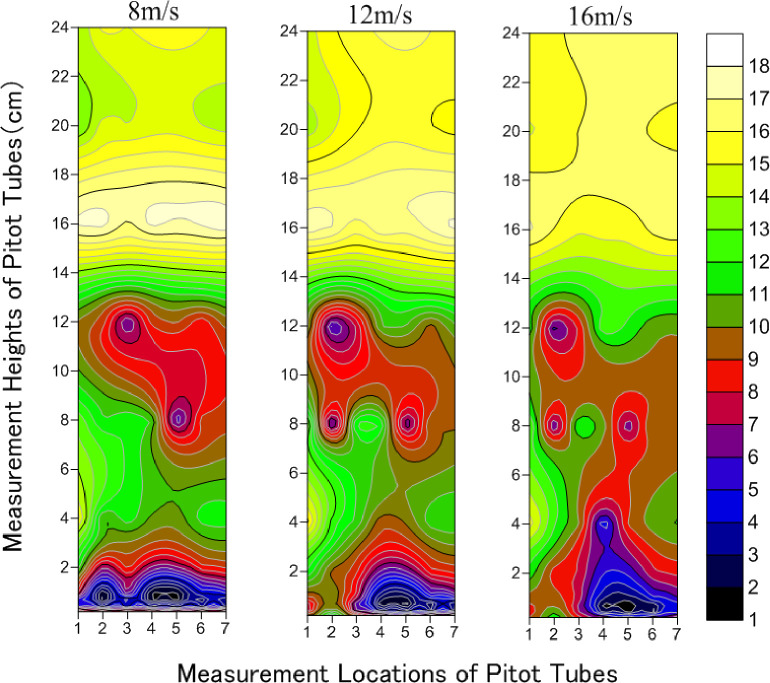
Distribution characteristics of airflow field in hemisphere-shaped synthetic shrubs under wind speeds of 8, 12 and 16 m/s.(Numbers 1–7 of horizontal axis correspond to -8.75 (the windbreak front), 8.75, 26.25 (within the windbreak), 43.75, 52.5, 87.5 to 122.5 cm (downwind of windbreak), respectively).